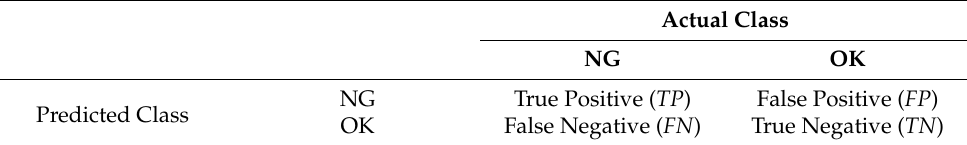
Table 3. Confusion matrix of the defect